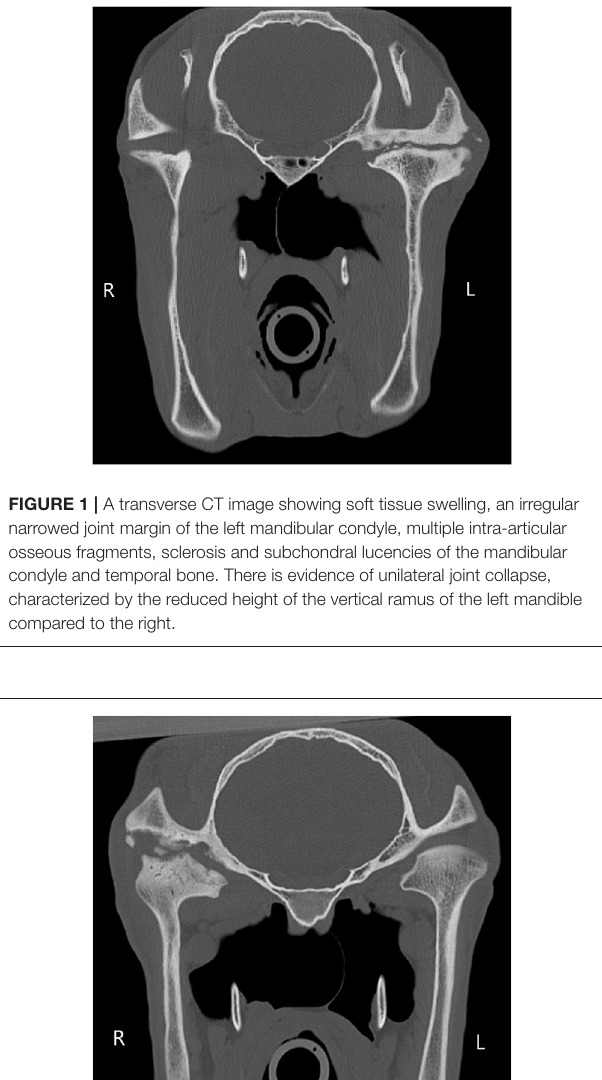
TABLE 3 | Post-operative